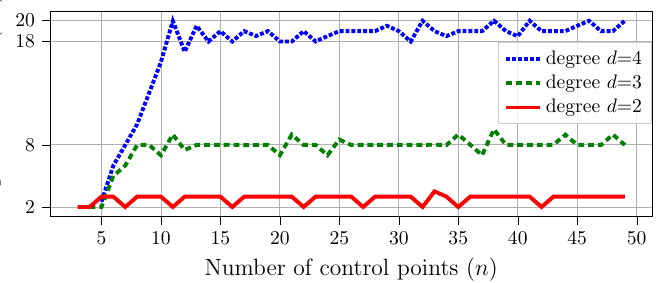
Figure 5. Computation time of the B-spline-to-Bézier conversion algorithm with respect to the number of control points and the curve’s